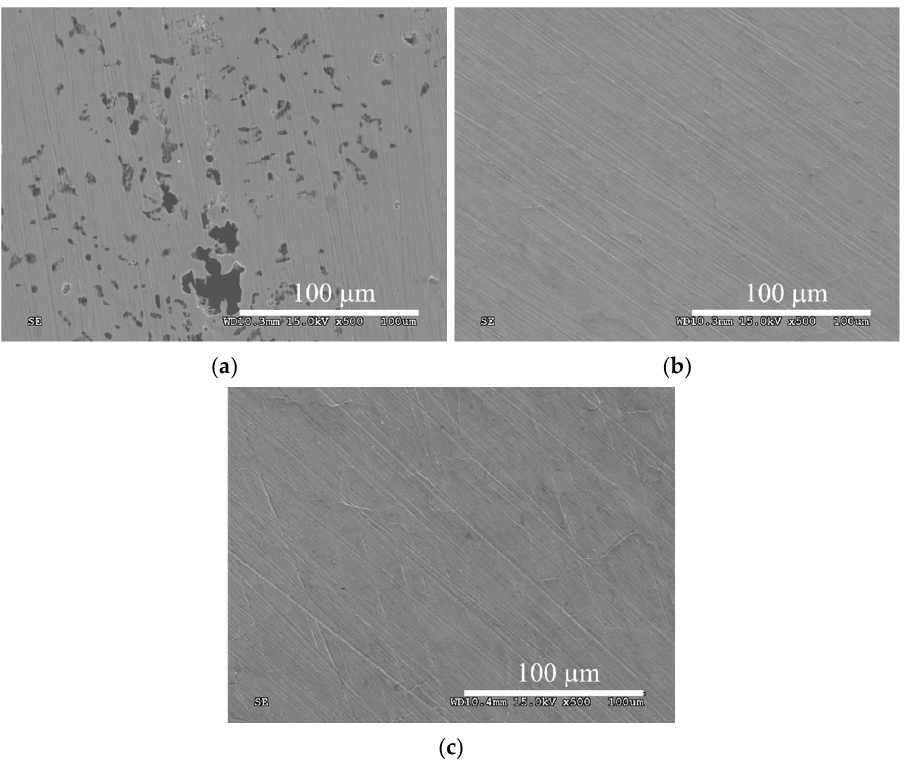
Figure 6. Images of the surface of AISI 316L steel in its initial state ( a ), following ASPN ( b ) and ASPNC ( c ) after potentiodynamic tests up to 1500